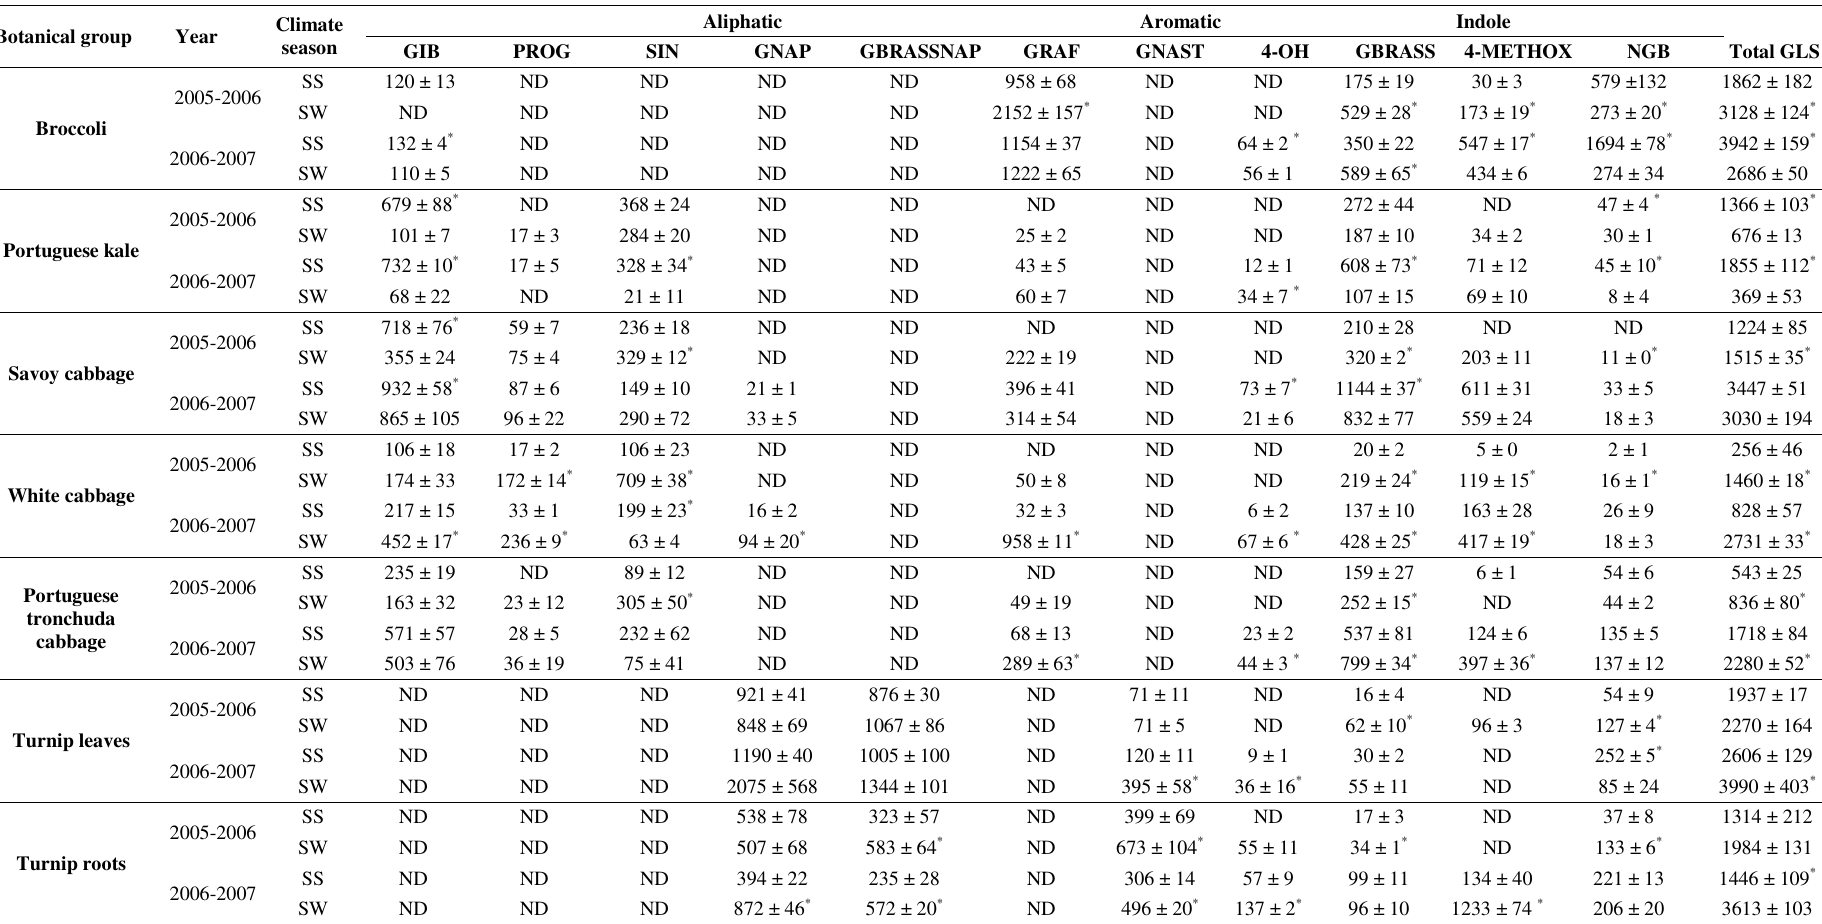
Table 1. Mean content of GLS (µmoles·100 g –1 d.w.) in different Brassica samples produced in two consecutive years and two different climate seasons [Spring-Summer (SS) and Summer-Winter (SW)].